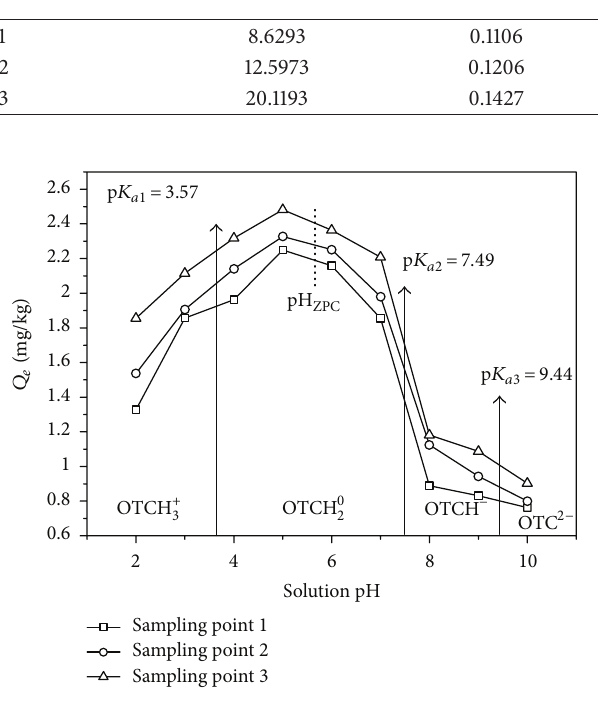
Figure 8: Effect of solution pH on OTC adsorption onto sediment samples as well as OTC existence forms in different pH conditions.